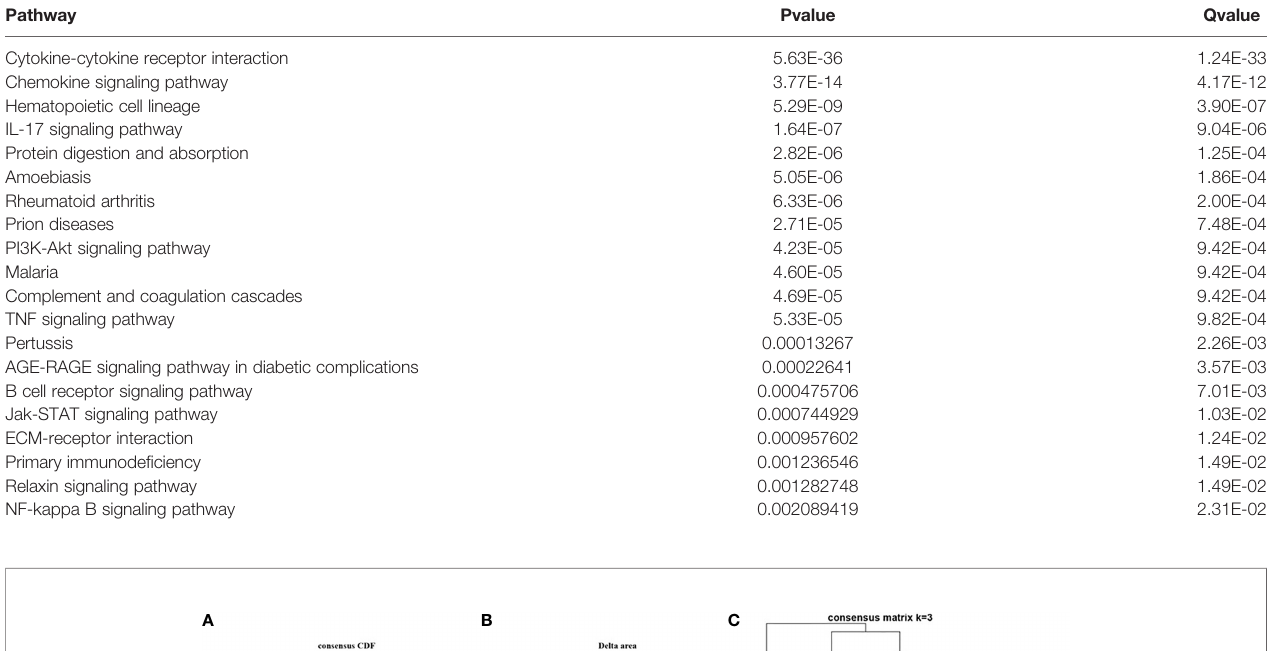
TABLE 2 | Top 20 KEGG pathways. Pathway